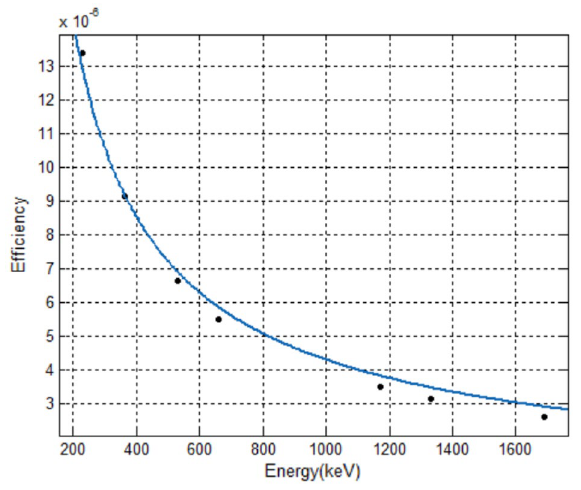
Figure 4. Fitting curve of HPGe γ spectrometer’s detection efficiency of radioactive surface source with characteristic γ-ray energy.